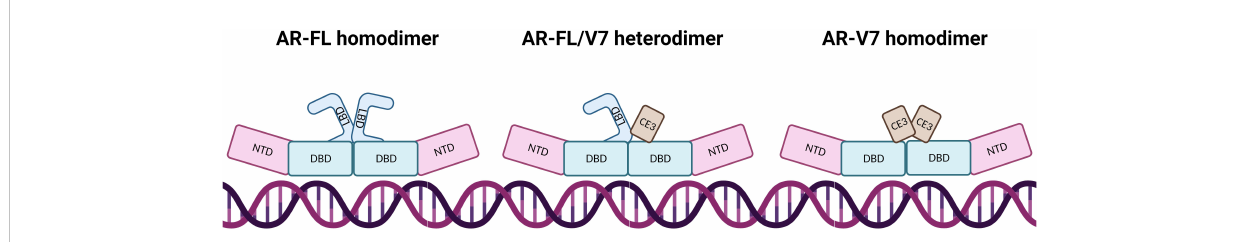
FIGURE 3 AR dimerisation and interaction with DNA. In AR-FL homodimers, the proteins intermolecularly associate by N/C interaction which is lost after DNA binding, allowing co-activator binding due to NTD and LBD separation. AR-FL/V7 heterodimers interact via N/C and D-Box interaction whereby the N/C interaction is also lost upon DNA binding. The AR-FL protein is immobilised on the DNA for a long time whereas AR-V7 protein demonstrates fast DNA-binding dynamics at high-af fi nity binding sites and dissociates from the dimer shortly after binding. AR-V7 homodimers have a short immobilisation time on the DNA, where dimers have close proximity via the